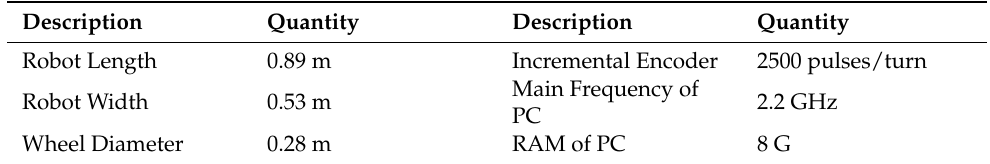
Figure 6. Motor’s input current with respect to the velocity .